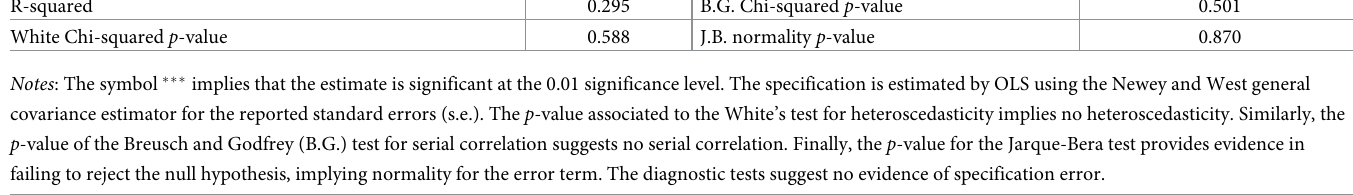
Table 3. Regression results for C þ